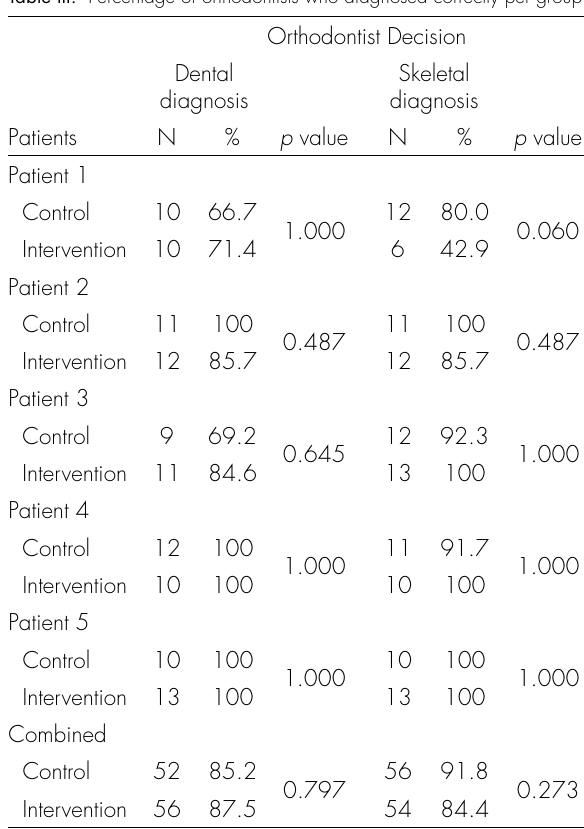
Table III. Percentage of orthodontists who diagnosed correctly per